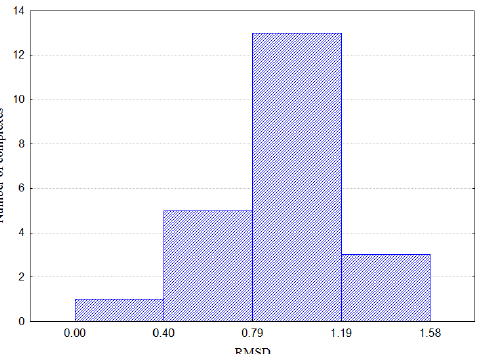
Figure 8. Histogram of the RMSD values ( X -axis) of superposed PPAR γ -full agonist complexes ( Y -axis).